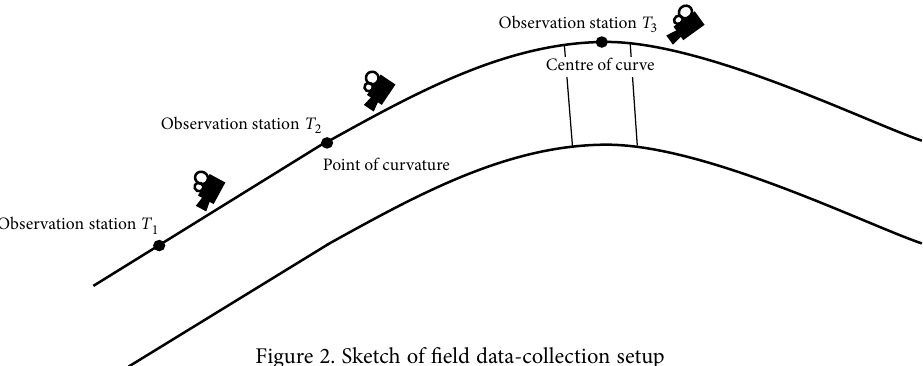
Figure 2. Sketch of field data-collection setup